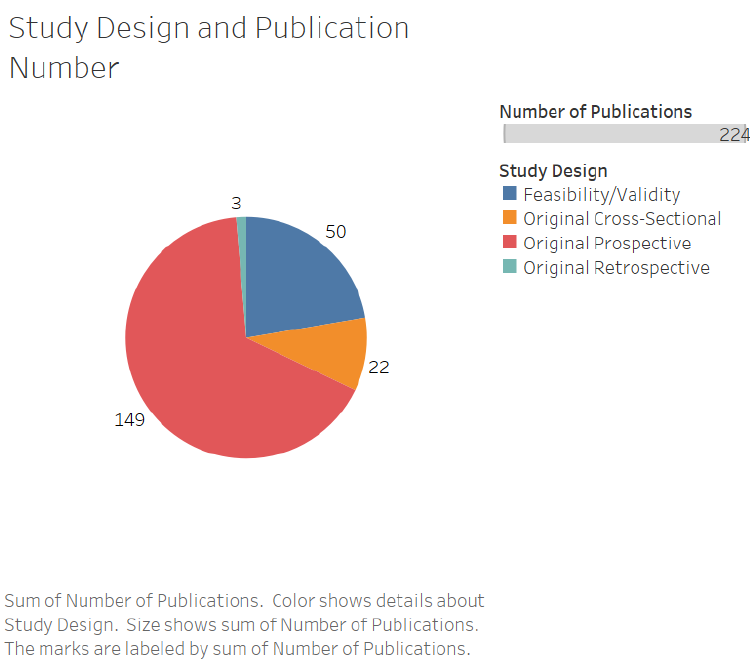
Figure 4. Pie chart representing the number of studies by study design.